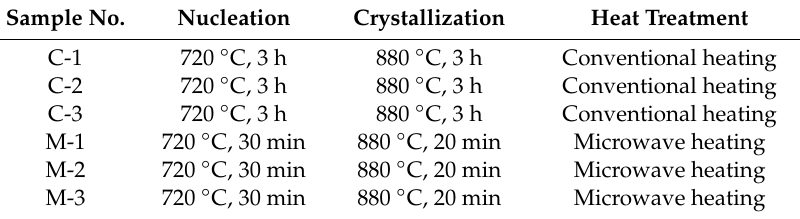
Table 2. Heat treatment process of glass-ceramics samples. Sample